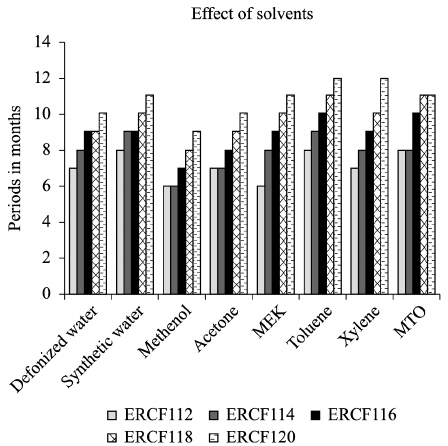
Figure 6. Graph of effects of solvents in epoxidized resole resin.